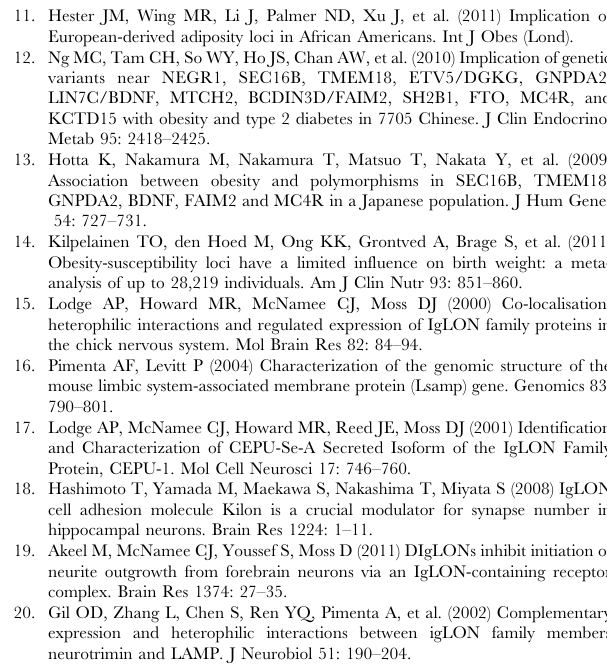
Figure S6 Normal brain anatomy in Negr1 -KO mice. A, B. Distribution of NPY-positive axons in the PVN and ARC. C.